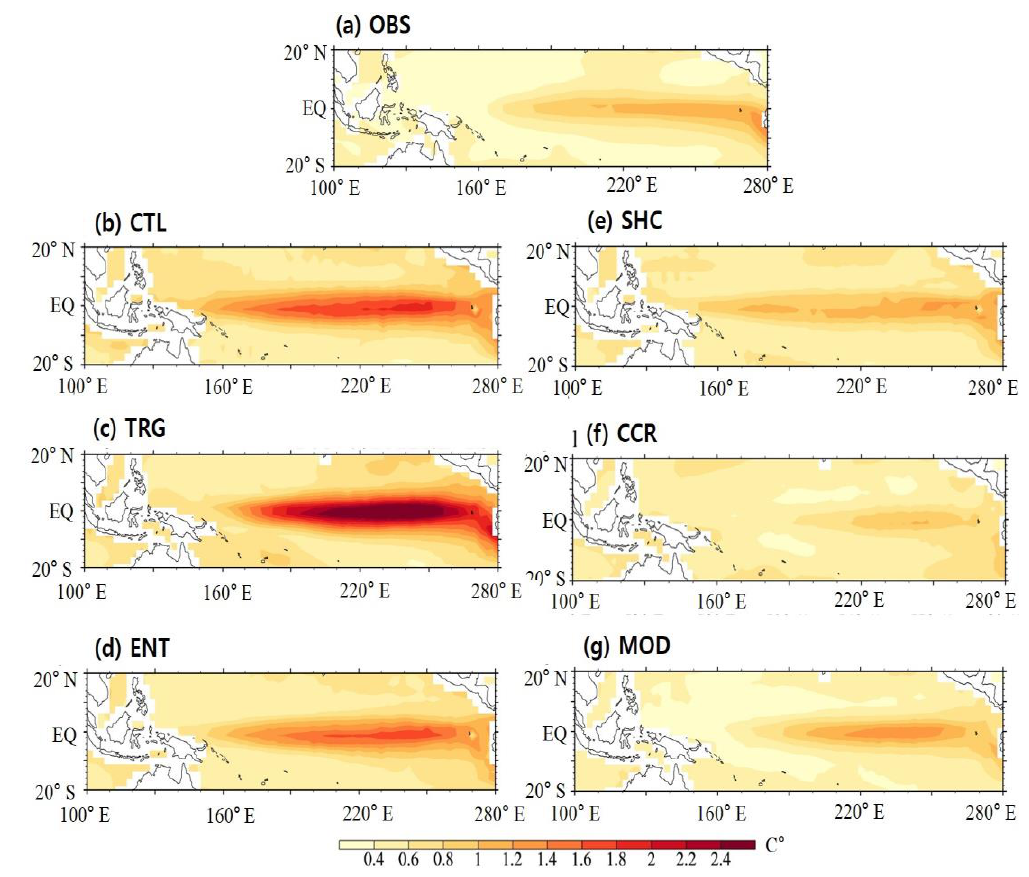
Figure 7. Standard deviation of interannual variability of monthly SST anomalies ( ◦ C) from: Figure 6. Standard deviation of interannual variability of monthly SST anomalies (°C) from: ( a ) ( a ) observation; and ( b – g ) NESM3.0 simulations with the modified observation; and ( b – g ) NESM3.0 simulations with the modified parameterizations.